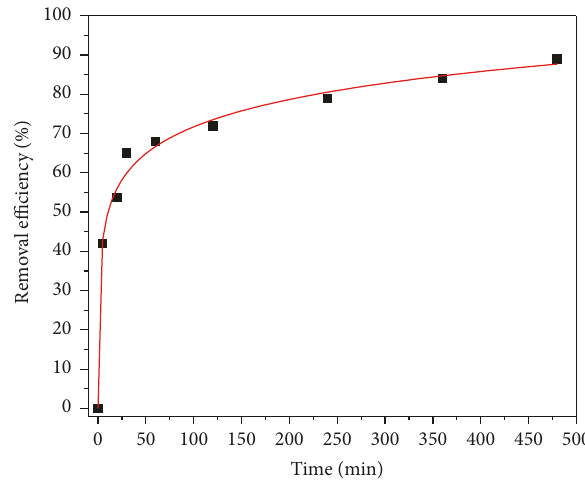
Figure 10: Effect of contact time on selenium removal (agitation speed = 150rpm, pH = 6, CNTs dosage = 10mg, and initial concen- tration = 1ppm).